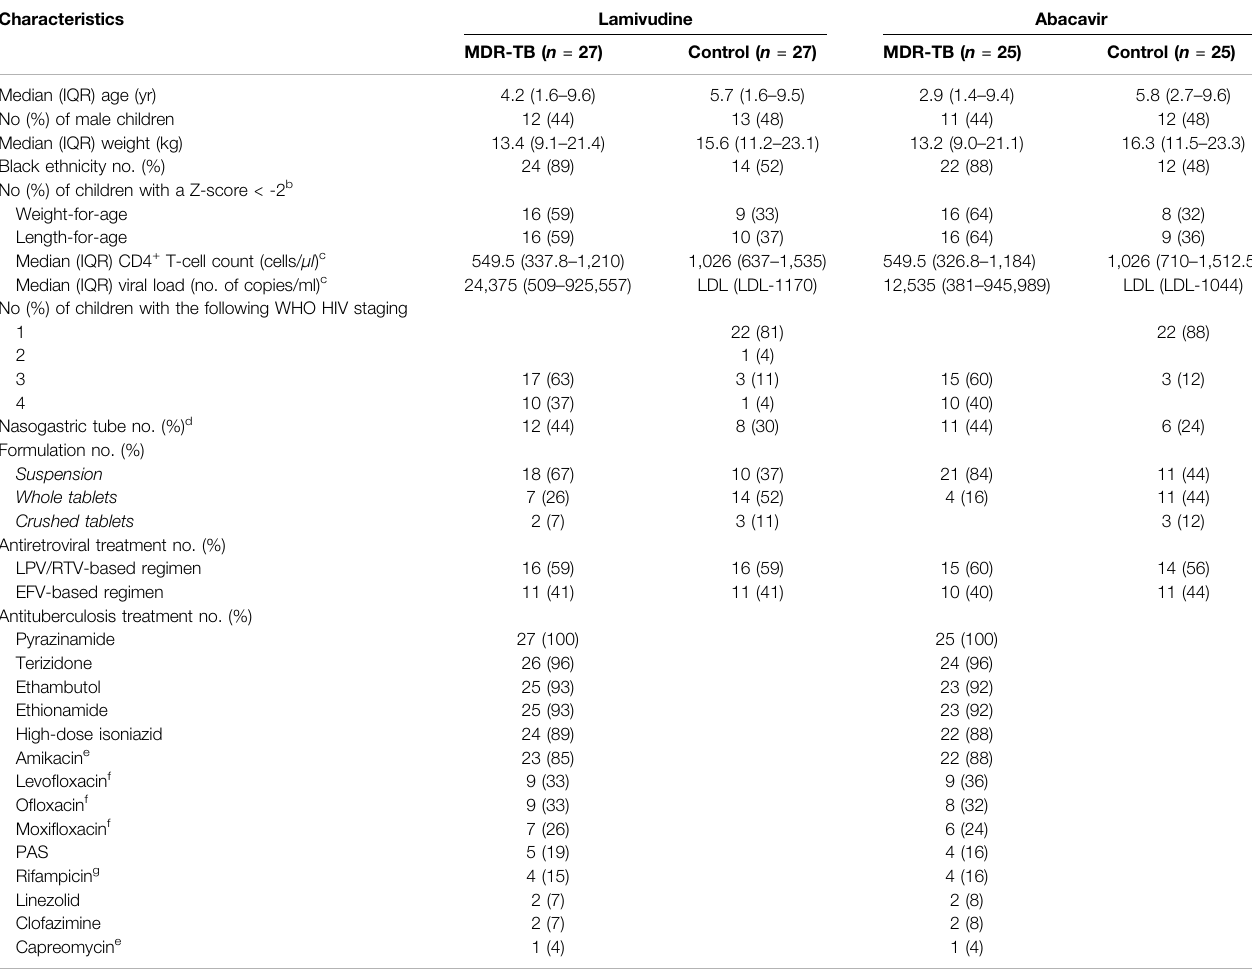
TABLE 1 | Summary of characteristics of HIV-positive children with and without MDR-TB on a lamivudine and abacavir – containing antiretroviral regimen a .